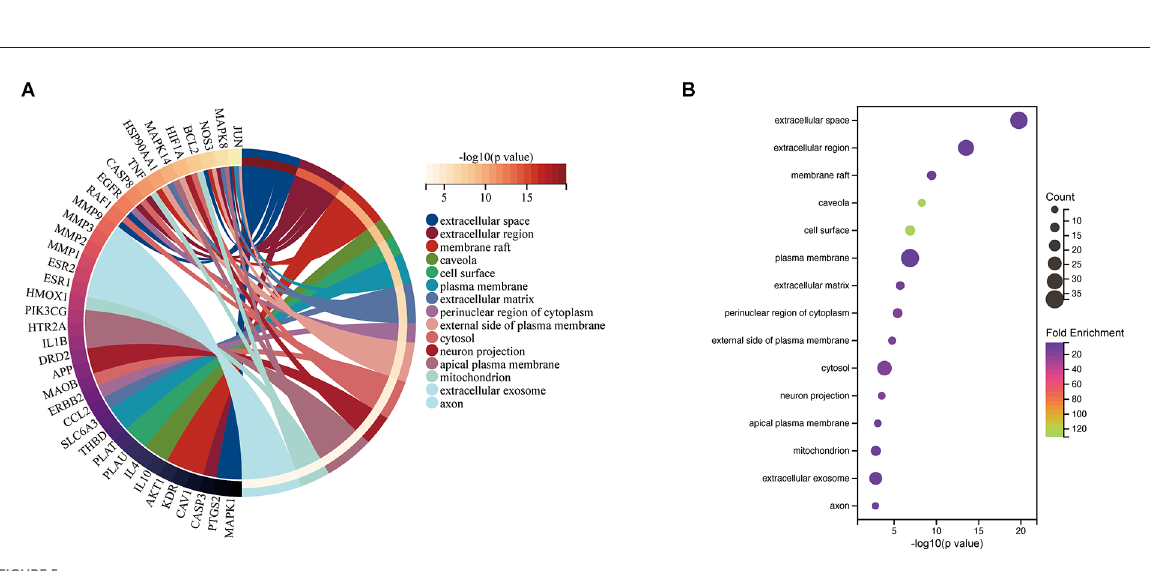
FIGURE5 CC associated with hub targets of Epimedium against VaD. (A) CC is presented by Circro diagrams. (B) CC is presented by bubble diagrams with CC term, − log10(p value), gene count, and fold